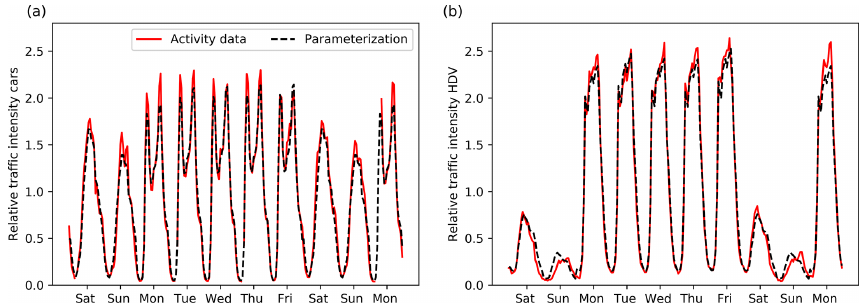
Figure 5. Time profiles of passenger cars (a) and heavy-duty vehicles (b) road transport on highways for 10 randomly chosen days in March. Solid red lines are based on true activity data, whereas dashed black lines are parameterizations based on averaged traffic counts for Rotterdam.